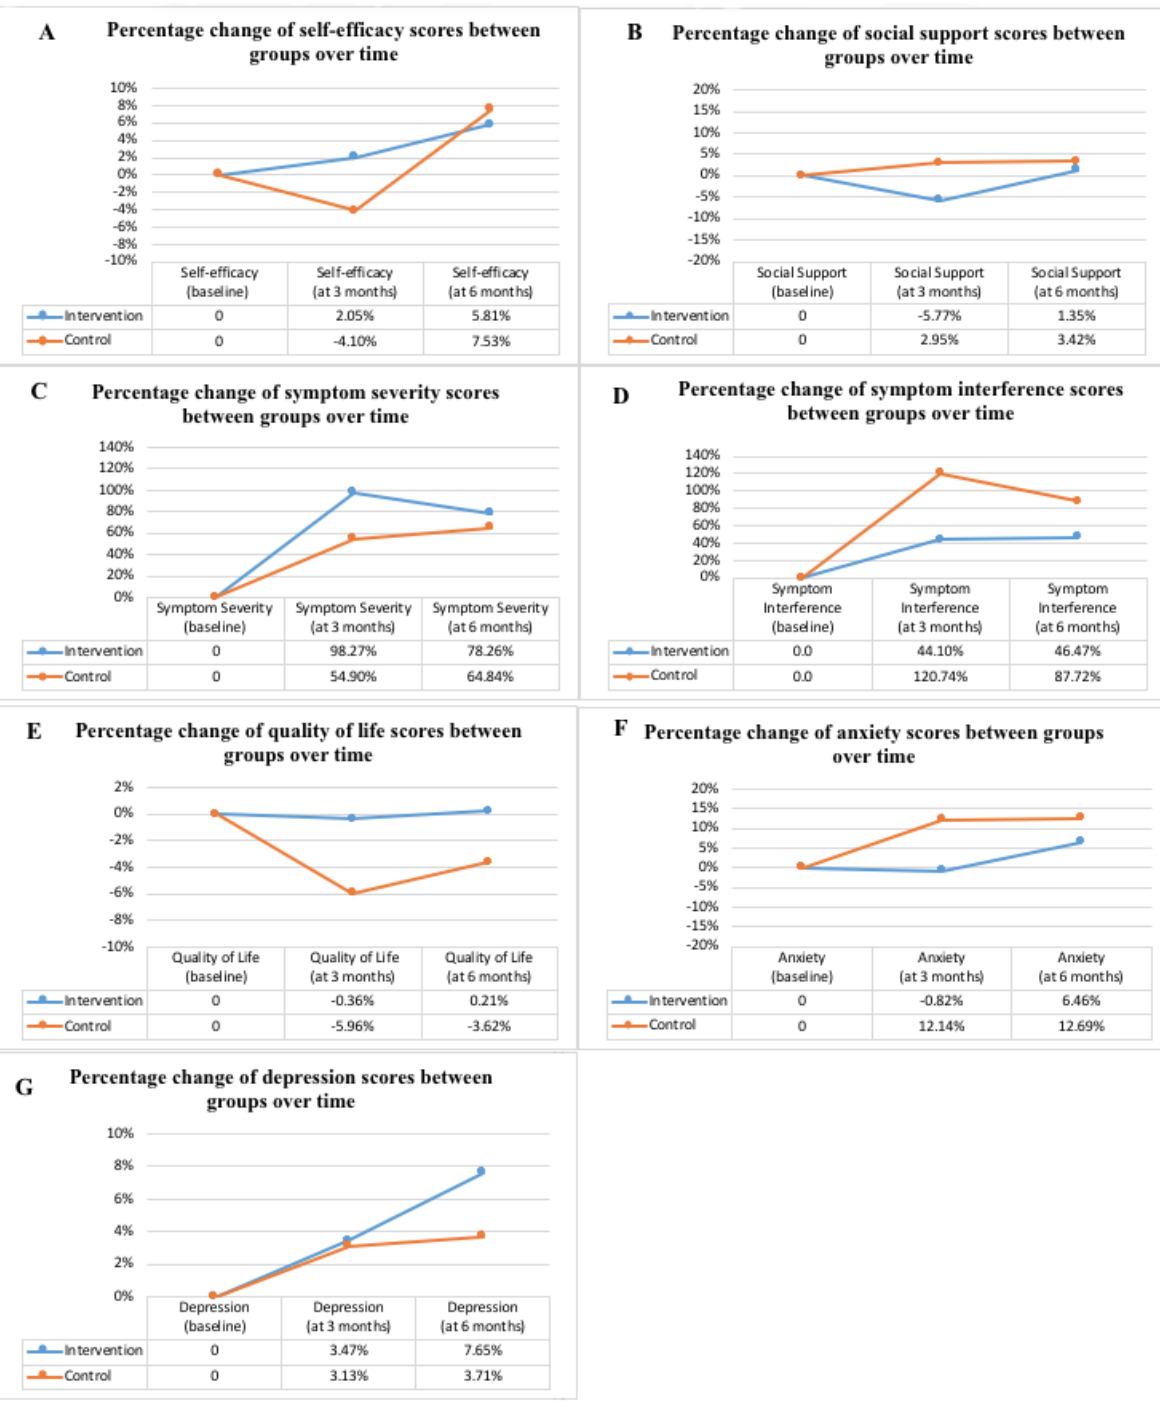
Figure 3. Mean percentage changes of health outcomes from baseline to posttests (n=114). Score at 3 months percentage change=(score at 3 months-score at baseline)/score at baseline; Score at 6 months percentage change=(score at 6 months-score at baseline)/score at